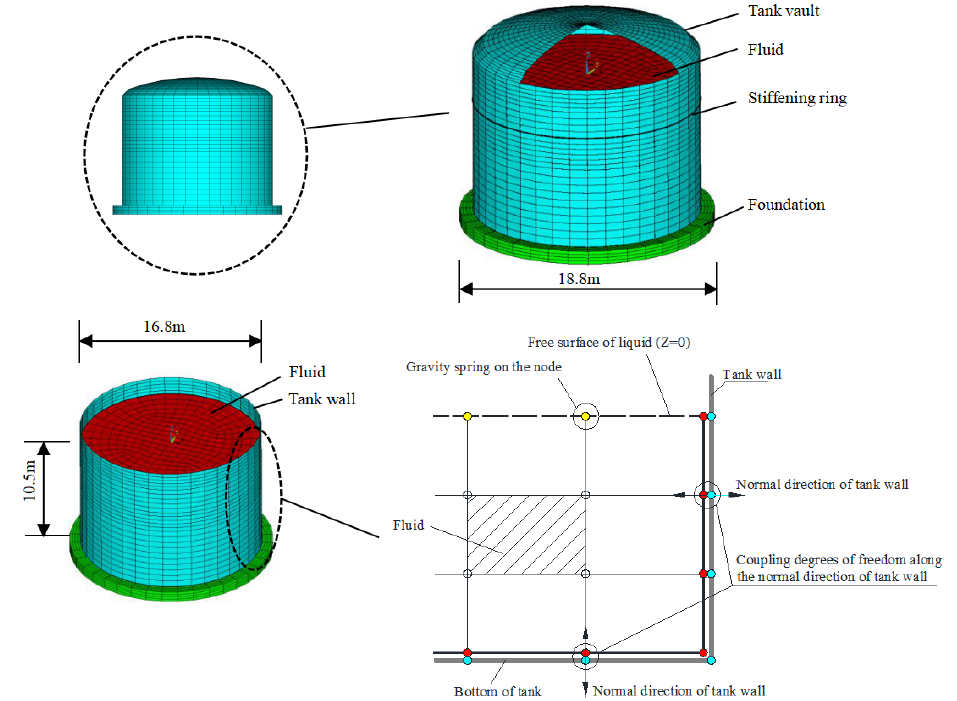
Figure 1. Finite element model of the fluid–tank–foundation system and a schematic diagram of the fluid–structure coupling.